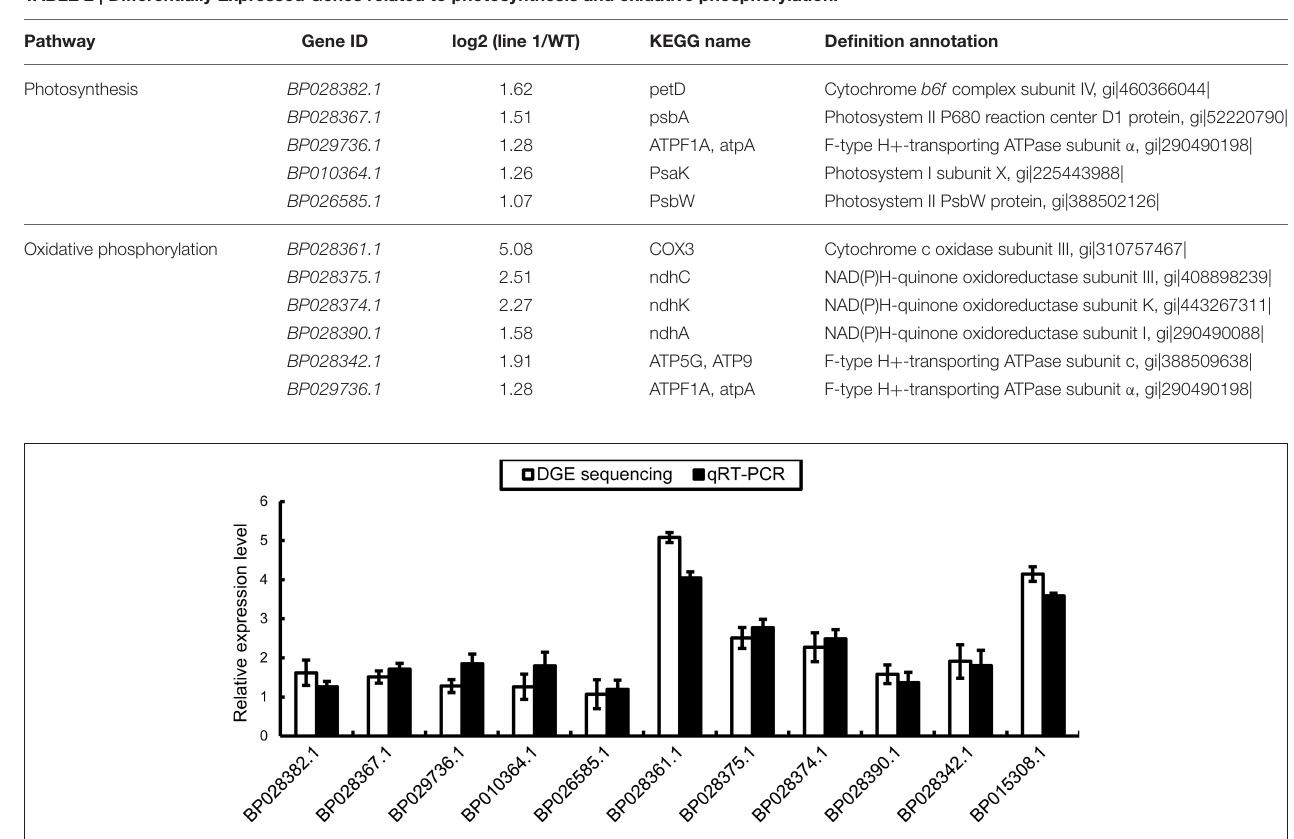
FIGURE 8 | qRT-PCR validations of DEGs in photosynthesis pathway and oxidative phosphorylation pathway. Genes were normalized using 18S as housekeeping genes. Error bars on each symbol indicate the mean ± SE with three replicate reactions.